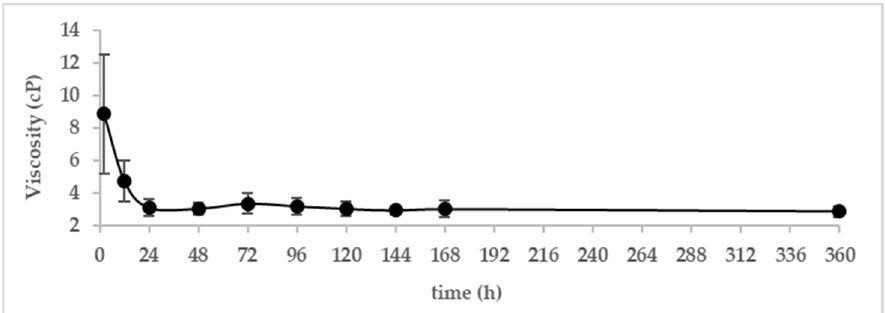
Figure 2. Variation in the viscosity of dromedary camel colostrum and milk during the first 7 days and on day 15 postpartum ( n = 16).